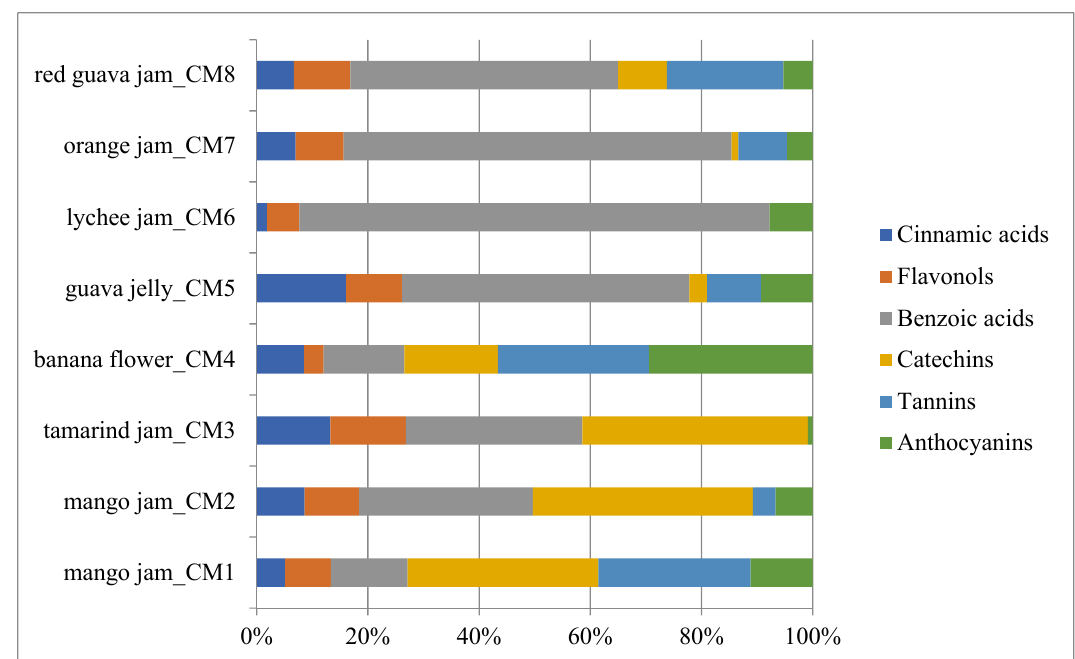
Figure 2. Polyphenolic phytocomplex representation of analysed fruit ‐ derived products. The mean value of each analysed sample is given ( N = 3).